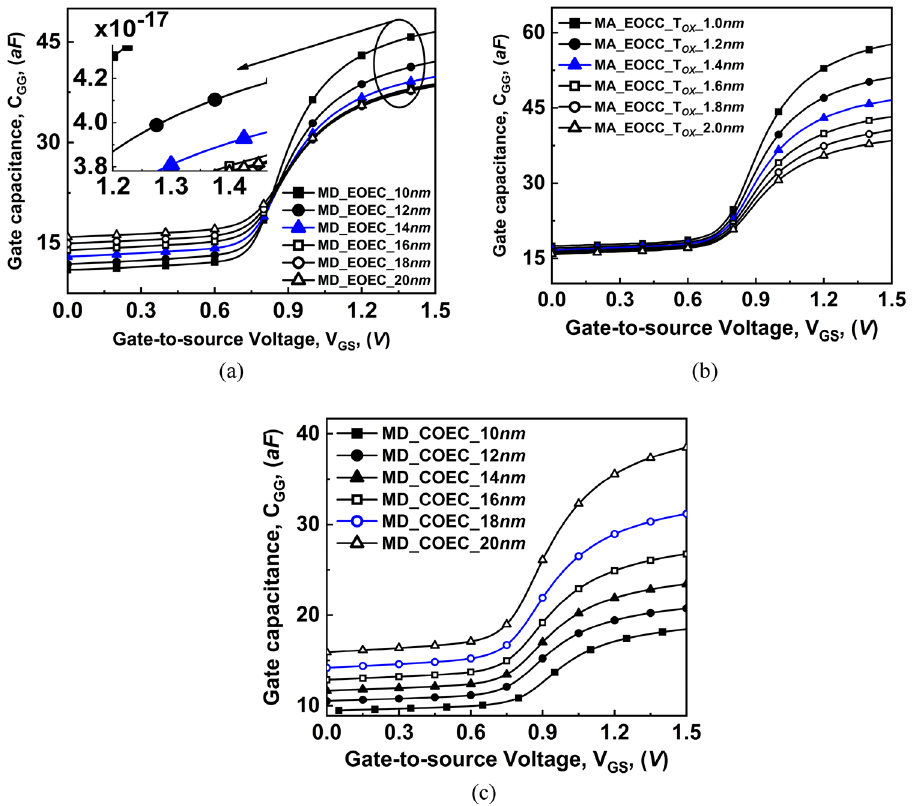
Figure 15. Comparison of variation of total gate capacitance as a function of gate voltage at V DS = 0.3 V of COCC structure with: ( a ) EOEC, ( b ) EOCC, and ( c ) COEC